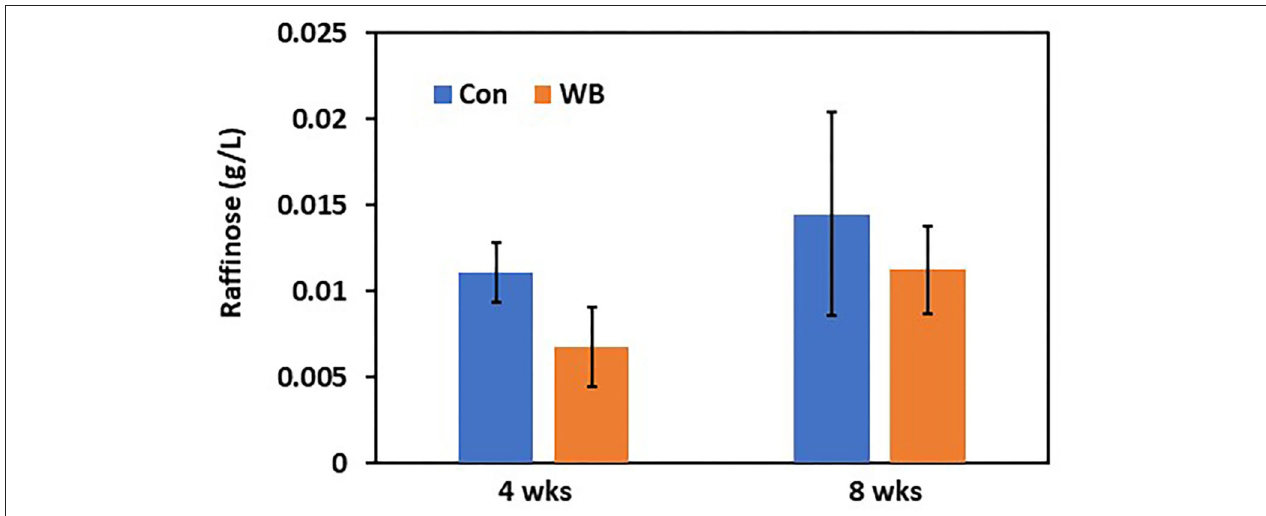
FIGURE 1 | Plasma raffinose concentration in WB and controls. Raffinose concentrations were determined at 4- and 8 wks of age. Bars indicate mean ± SE.